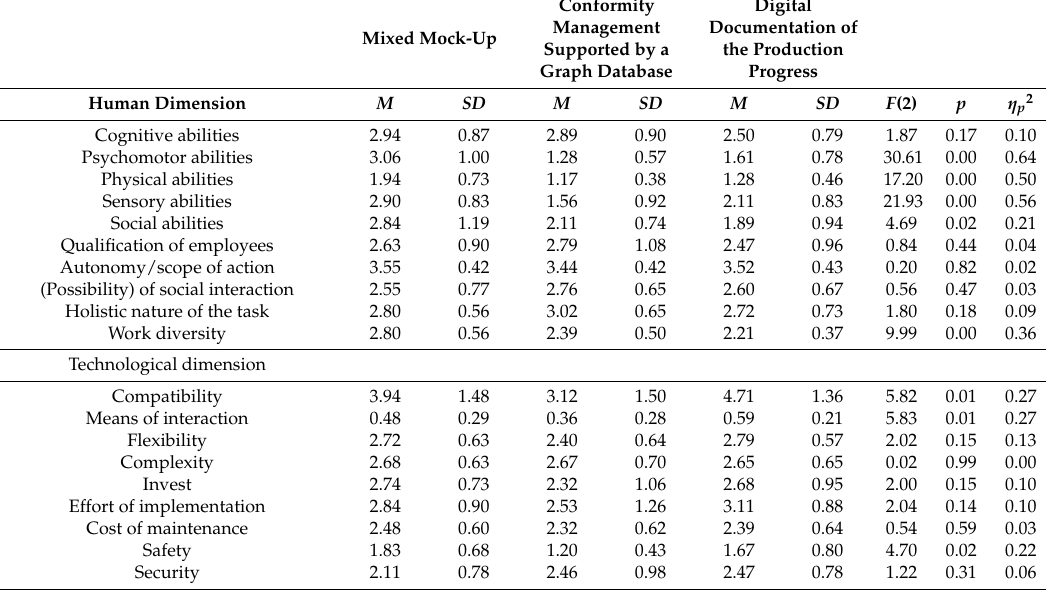
Table 3. Descriptive statistics and statistical values of the analysis of variance of all factors for the dimensions human, technology and